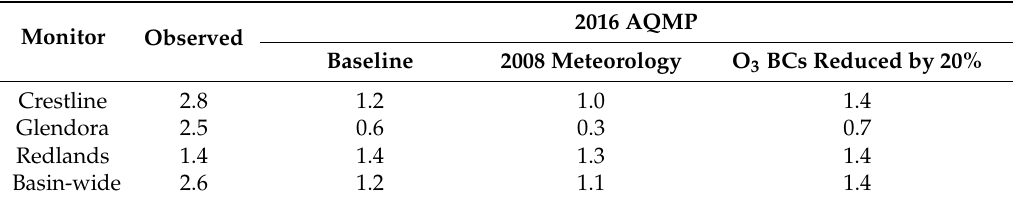
Table 3. 2016 AQMP ozone reduction rates (ppb/year) in 3 year ozone design values for the 2008–2015 period for the baseline case and for the meteorology and boundary condition sensitivity studies. 2016 AQMP Monitor Observed 2008